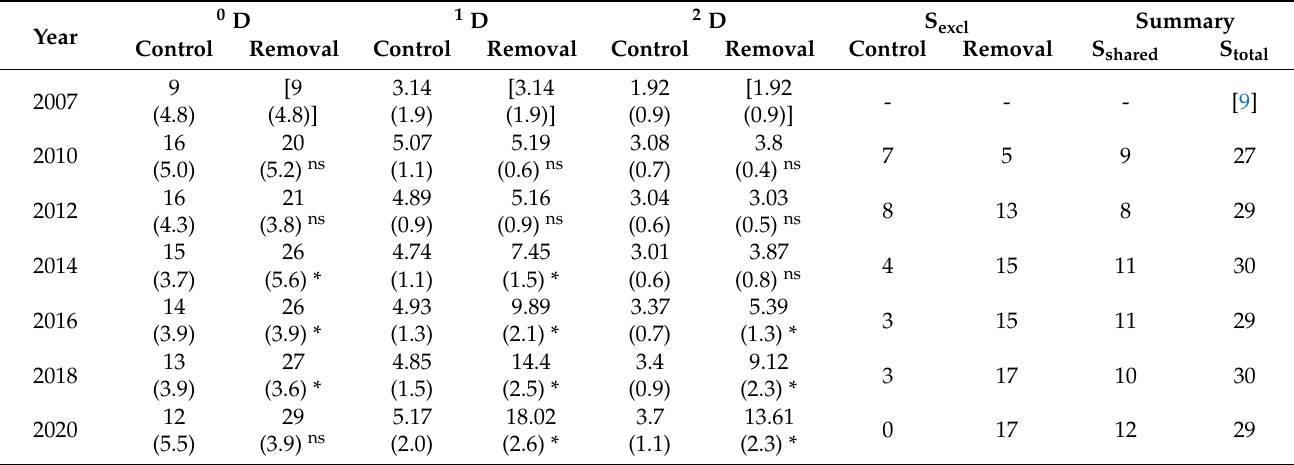
Table 1. Calculated tree species diversity for control and removal plots based on empirical Hill numbers ( q D; q = 0 to 2), number of species exclusive to one forest type (S excl ), number of shared species between forest types (S shared ), and total number of species in both forests (S total